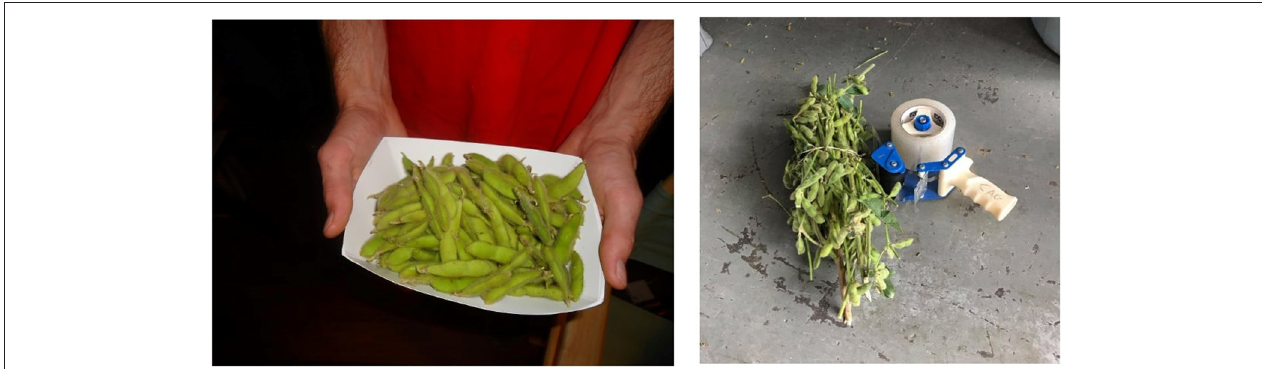
FIGURE 1 | Pictures of edamame end products. Edamame supplied as pre-stripped pods is predominantly consumed in the United States today, while edamame supplied as “on the stalk” (right) is more commonly preferred in East Asia for its added freshness.